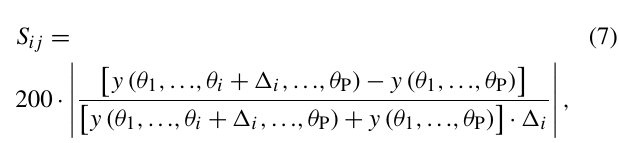
Event-based sub-